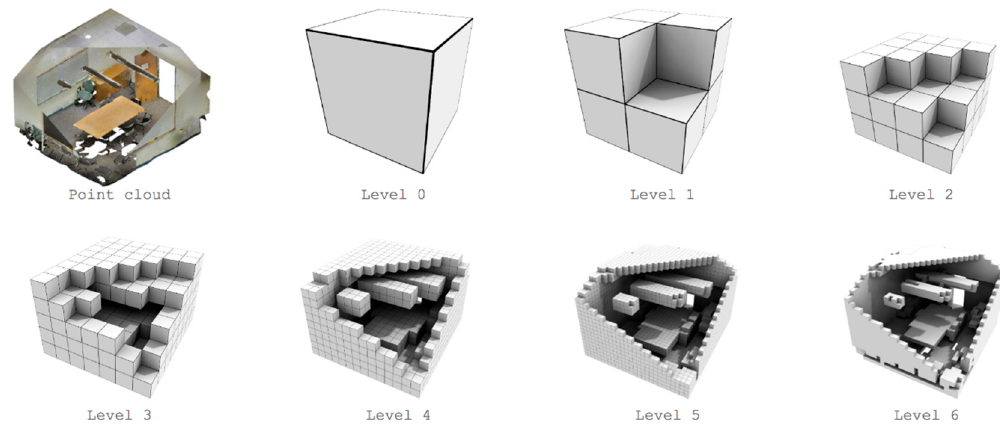
Figure 4: Point Cloud and its extracted voxel structure, where each octree level represents the grid voxels, each subdivided in subsequent eight voxel children.